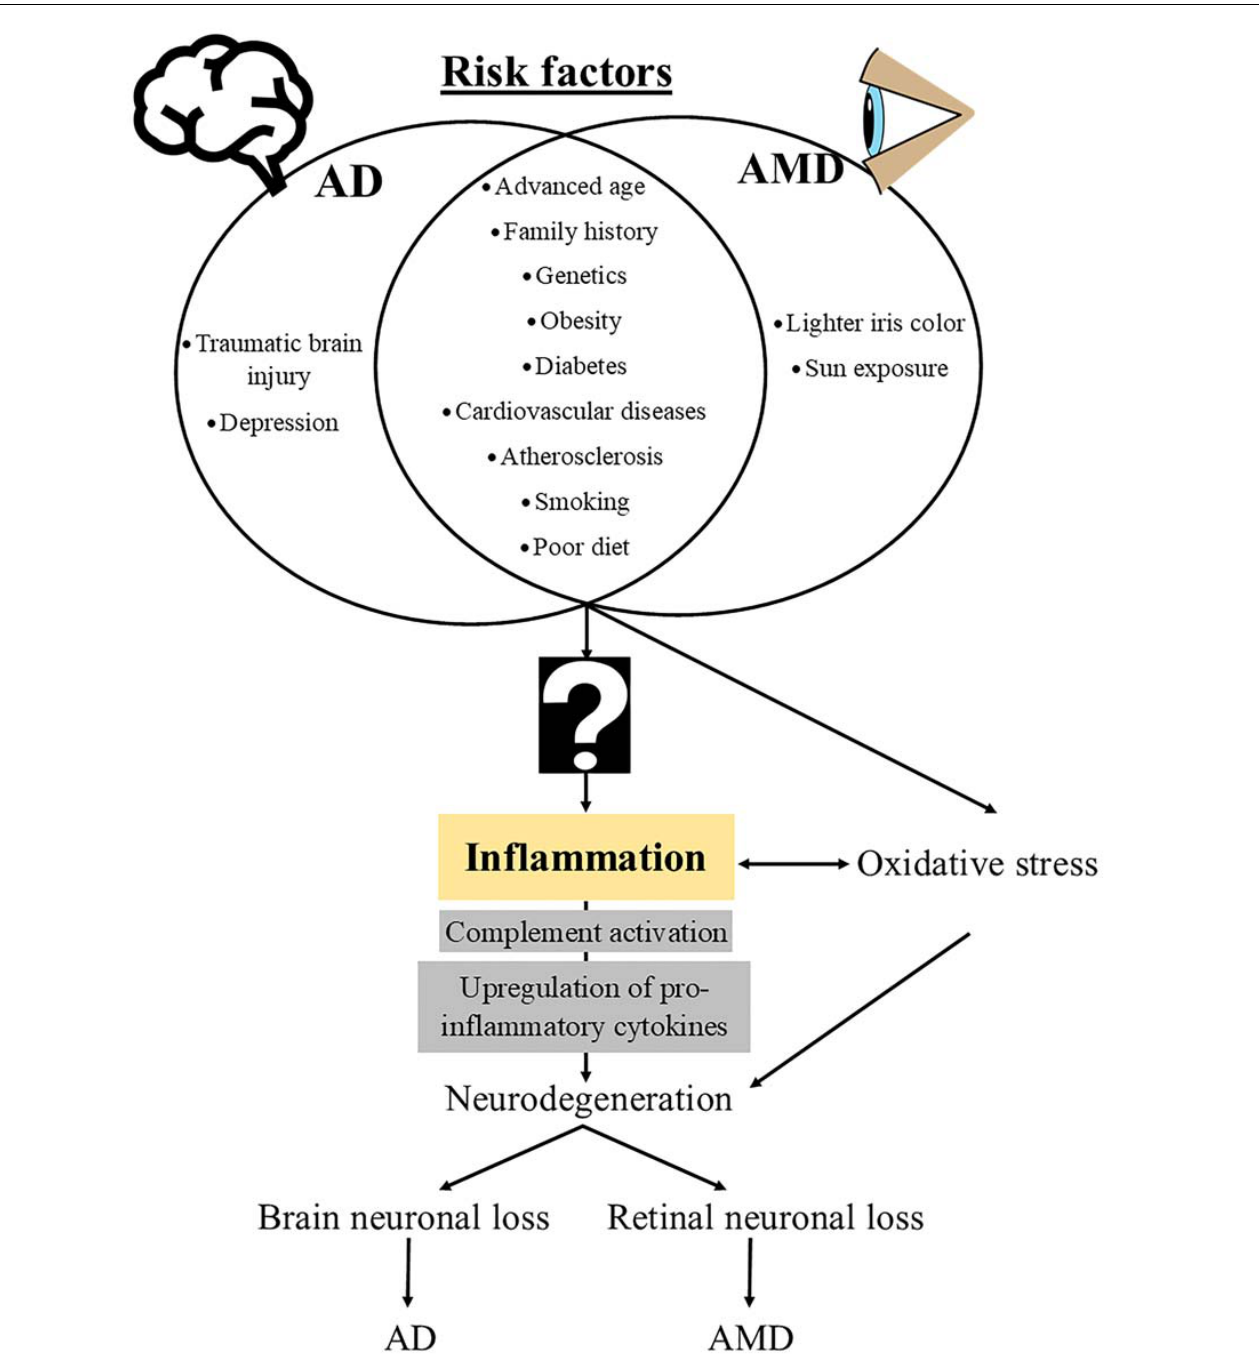
FIGURE 1 | Schematic diagram of risk factors and mechanistic events that underlie the pathogenesis of Alzheimer disease (AD) and age-related macular degeneration (AMD). The question sign indicates an unknown, potentially “infectious” contributor to the downstream immunopathological cascades that are common in both AD and